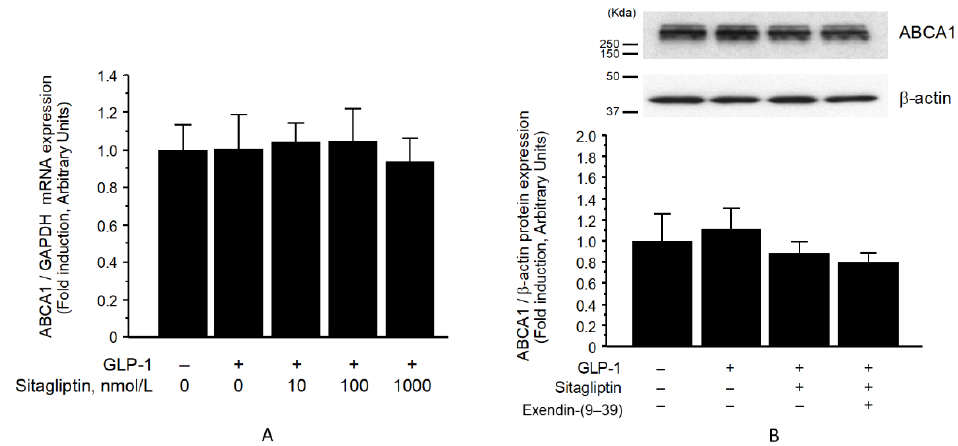
Figure 3. Effect of sitagliptin in the presence of GLP-1 (10 nmol/L) on ABCA1 mRNA ( n = 8–12) ( A ) and protein ( n = 5) ( B ). Expressions in whole-cell lysates of THP-1 cells. Values represent mean ± SD. Abbreviations: ABCA1, adenosine triphosphate-binding cassette transporter A1; GAPDH, glyceraldehyde-3-phosphate dehydrogenase.